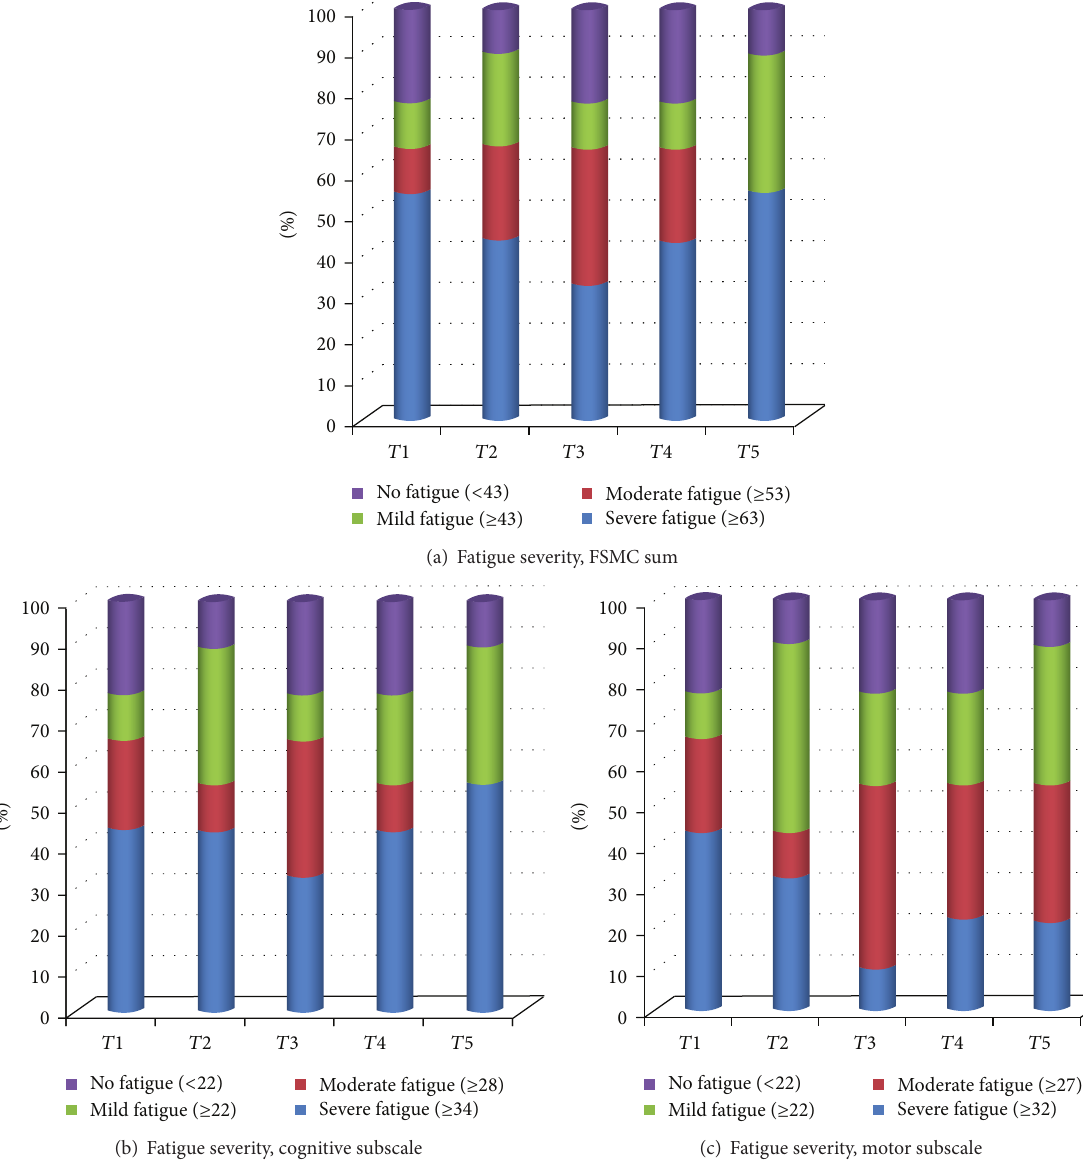
Figure 2: Longitudinal data of the number of patients with their graded fatigue for the sum, cognitive and motor subscales of the FSMC. The timeline of the 5 assessments is presented in the X axis. The percentage of participants is presented in the Y-axis. Different colours are indicating the severity, based on cut-off values, as indicated. The number of severely fatigued participants changed over time, especially for the motor subscale. Four subjects started with severe motor fatigue, including 2 subjects with EDSS 4 ( 𝑇1 ). A transient reduction occurred in 3 of them, just before travelling to Peru ( 𝑇3 ). Severe motor fatigue came back in 1 subject, which results in 2 subjects with severe motor fatigue ( 𝑇5 ), both with EDSS 4 at